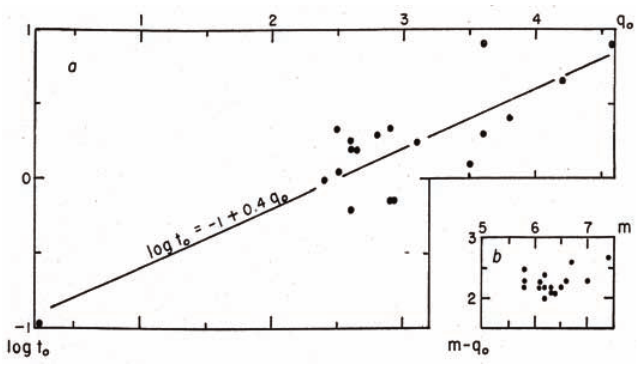
Figure 6. Two important equations are derived from plotted data: log t = – 1 + 0.4 t and q = m – 2.3. o o o